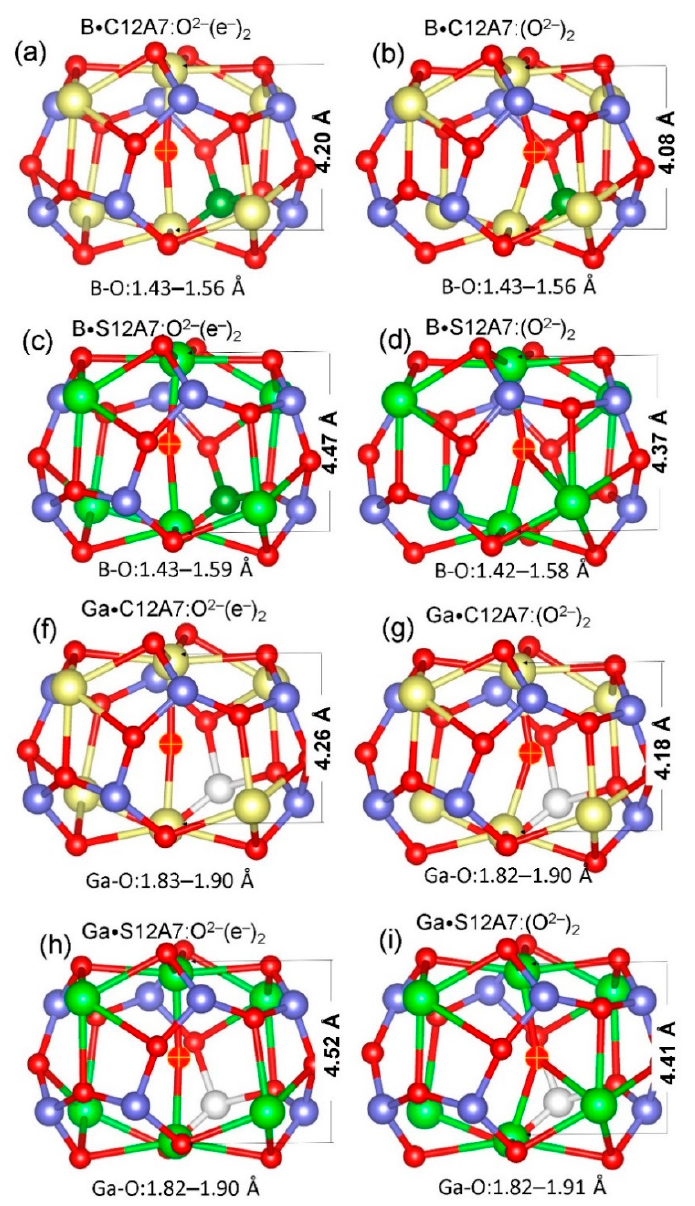
Figure 7. Relaxed cage structures containing encapsulated oxygen atoms in ( a – d ) B-doped and ( f – i ) Ga-doped electrides. Table 5. Calculated lattice parameters and volumes of oxygen encapsulated doped structures.